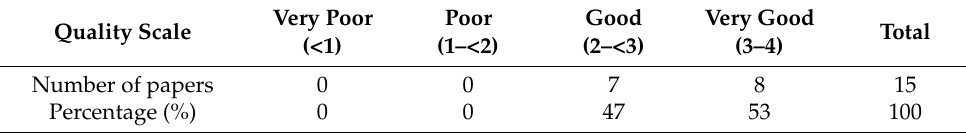
Table 4. Quality assessment score.